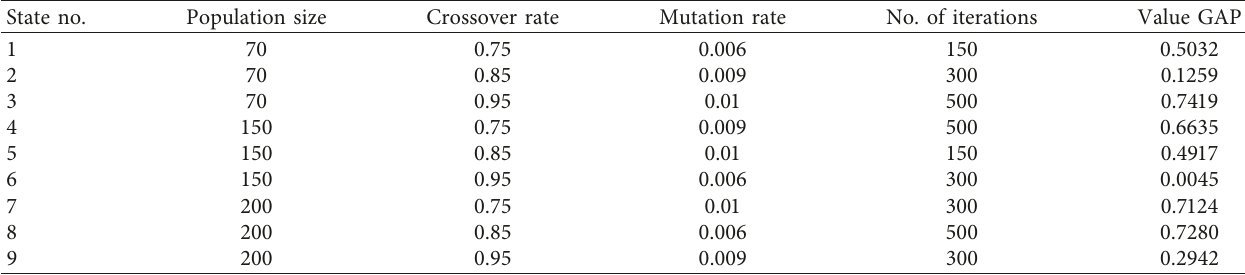
Table 5: Genetic algorithm orthogonal.